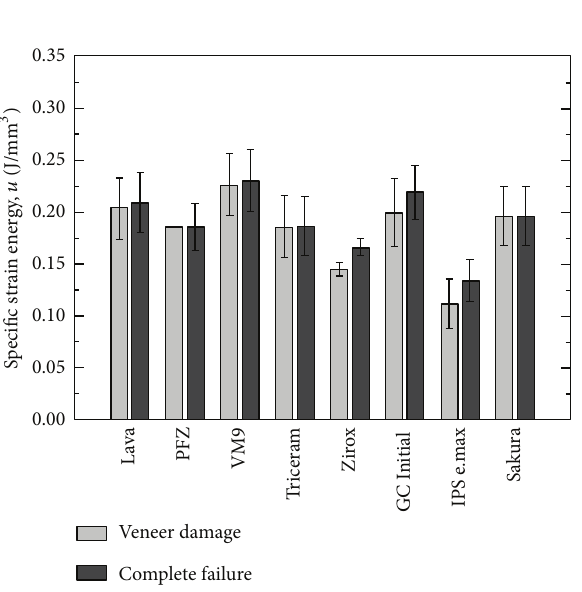
Figure 2: Strain energy per unit volume at failure and veneer damage for the two-layered